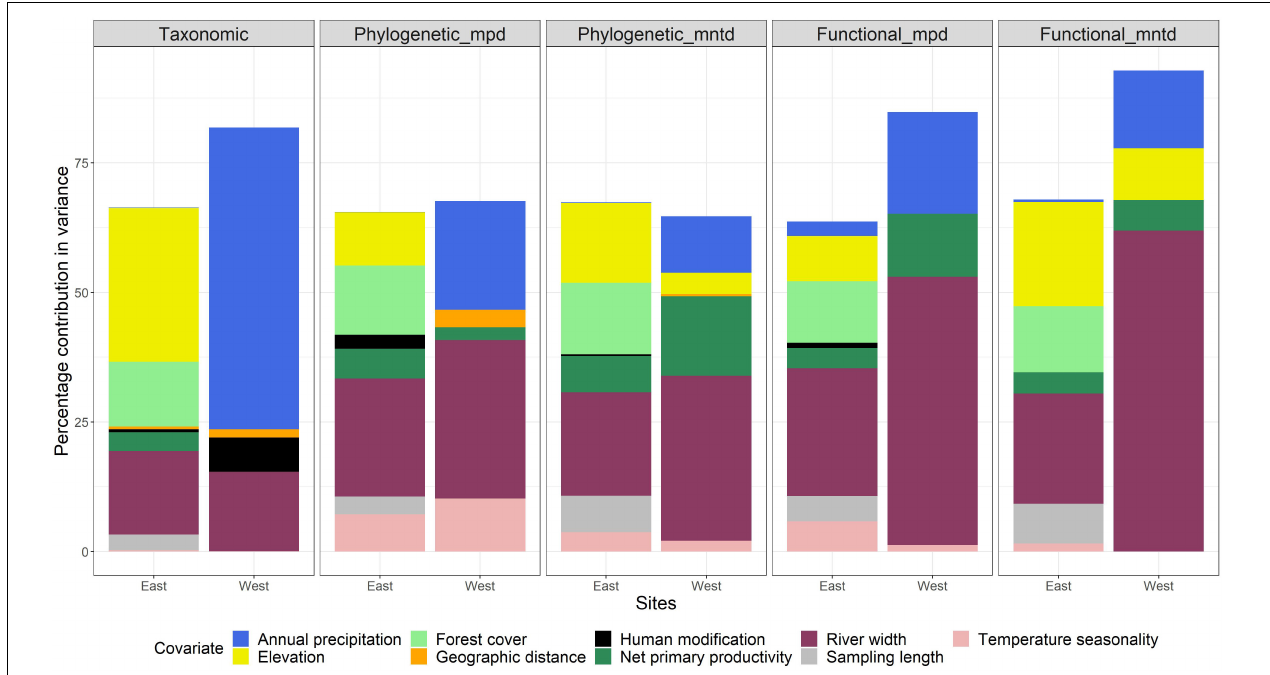
FIGURE 5 | Variance partitioning of different predictor variables across beta diversity measures (taxonomic, phylogenetic, and functional) for river birds at different scales.